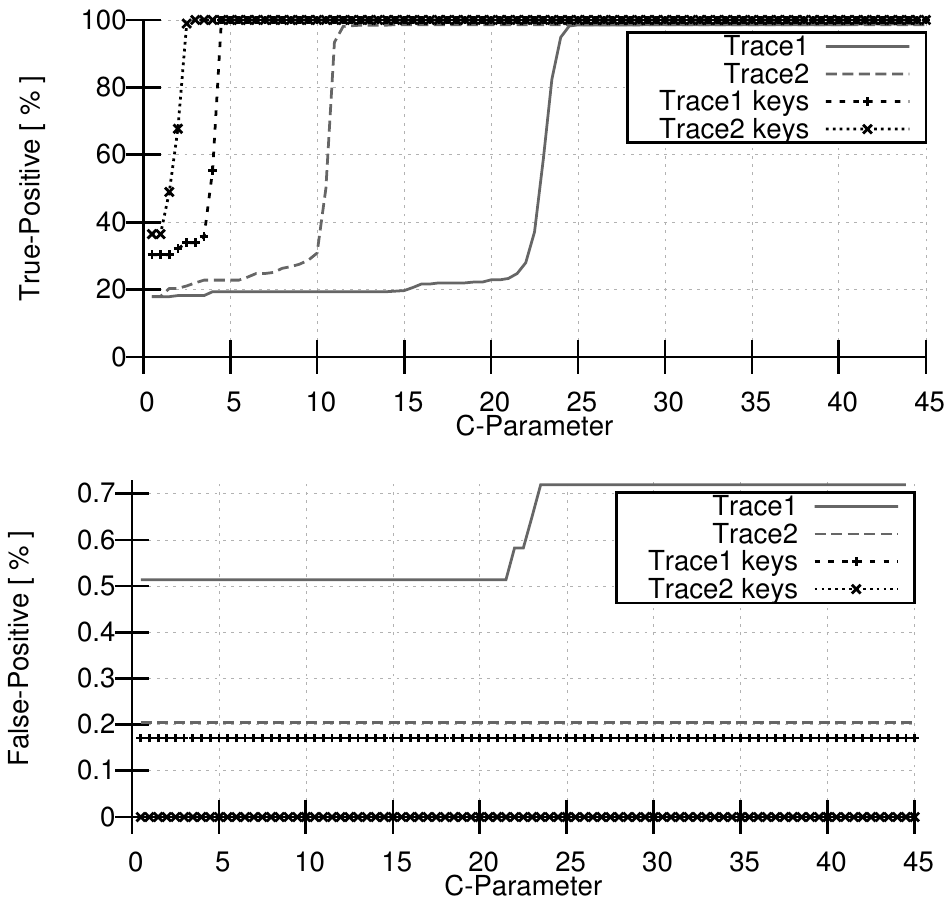
Figure 4. Comparison of the C-parameter impact with and without the keyword extension: true positive rate (top), false positive rate